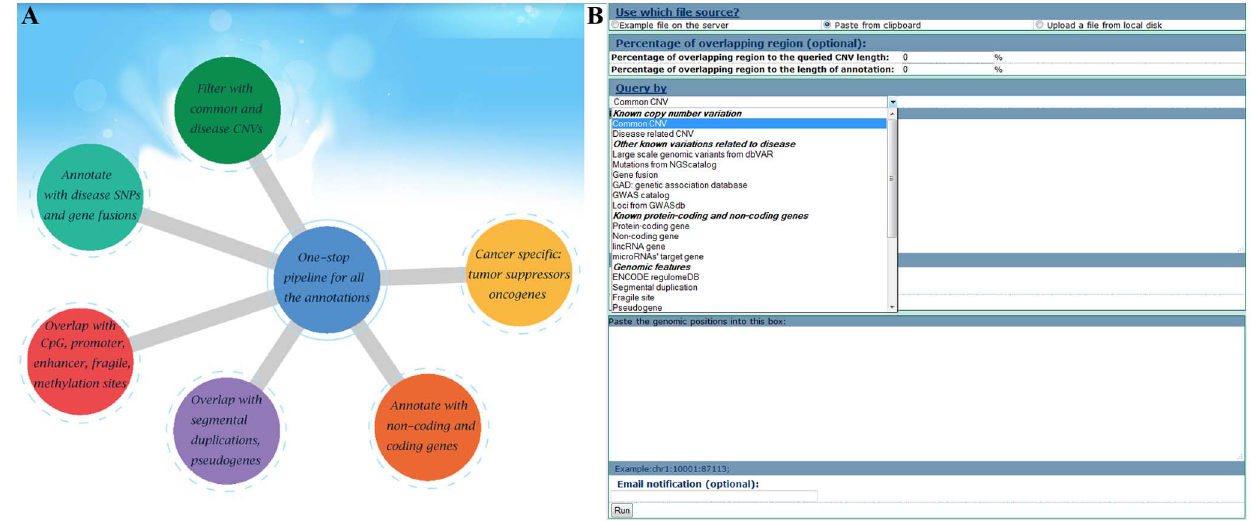
Figure 3. The genomic region-based query viewer in CNVannotator. (A) The access to various analytic tools for numerous functional annotation modules. (B) The web interface to input a list of CNVs for annotation. In the drop-down menu, users can choose the most relevant annotation option.